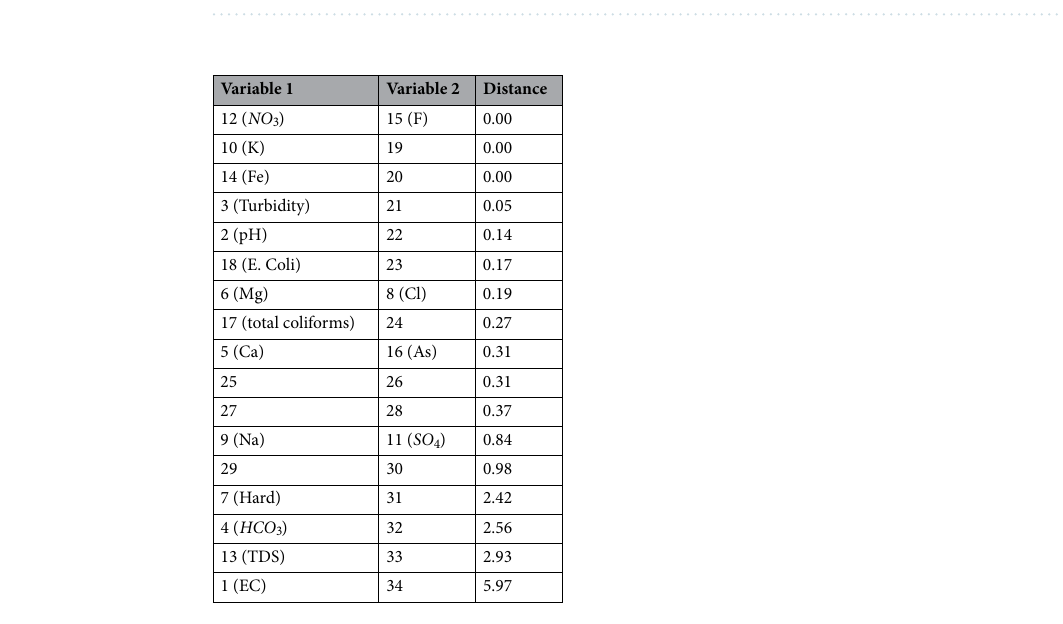
Table 7. Numbers assigned to variables for cluster analysis.